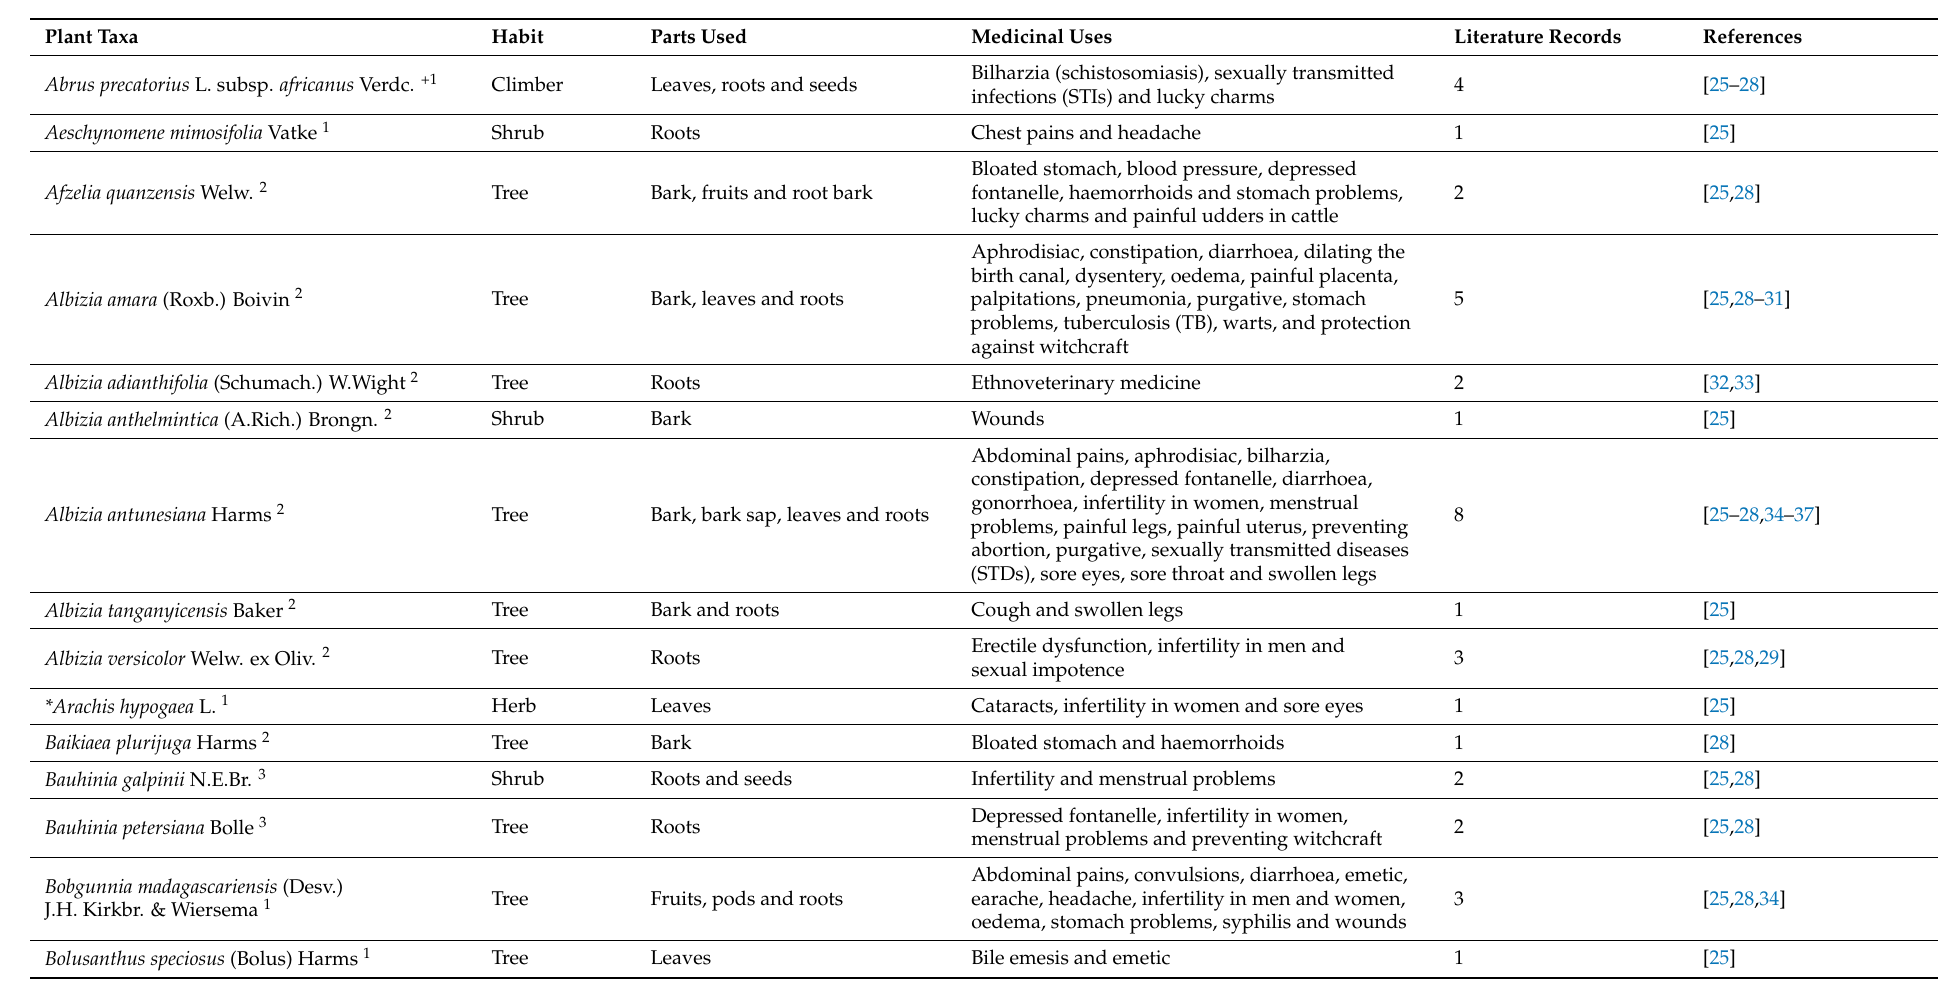
Table 1. Medicinal Fabaceae plants of